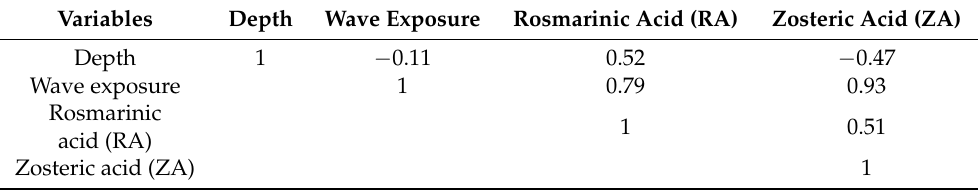
Table 3. Principal component analysis (PCA) partial correlation coefficient table for the variables; depth, wave exposure, rosmarinic acid (RA) and zosteric acid (ZA)—describing 71% of the variance. Variables Depth Wave Exposure Rosmarinic Acid (RA) Zosteric Acid (ZA) Depth 1 − 0.11 0.52 − 0.47 Wave exposure 1 0.79 0.93 Rosmarinic 1 0.51 acid (RA) Zosteric acid (ZA)